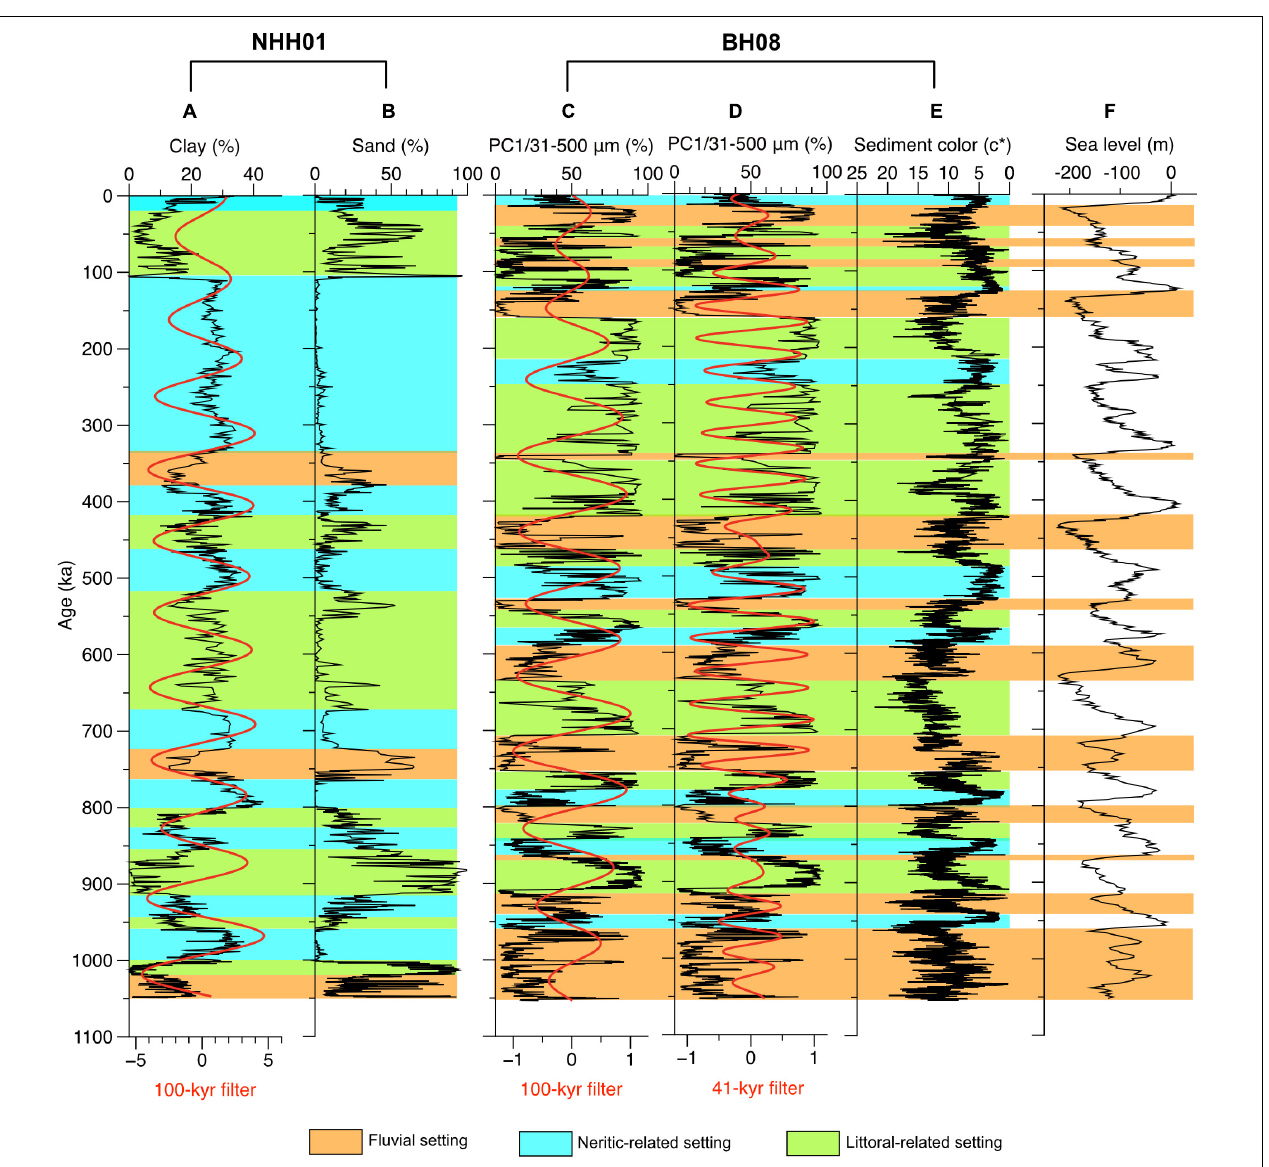
FIGURE 7 | Sedimentary environment and proxies of core NHH01 from the Yellow Sea (this study) compared with proxy records of core BH08 from the Bohai Sea (Yao et al., 2020), and their comparison with the global sea-level curve (Miller et al., 2005). Clay content and its filtered 100-kyr signal (red line; A ), sand content of core NHH01 (B) , PC1 (31–500 µ m) of core BH08, a proxy indicating the littoral deposits caused by sea-level change, and its filtered 100-kyr and 40-kyr signals (red line; C,D ), sediment color c* ( E ; Shi et al., 2016) and global sea-level curve ( F ; Miller et al., 2005).